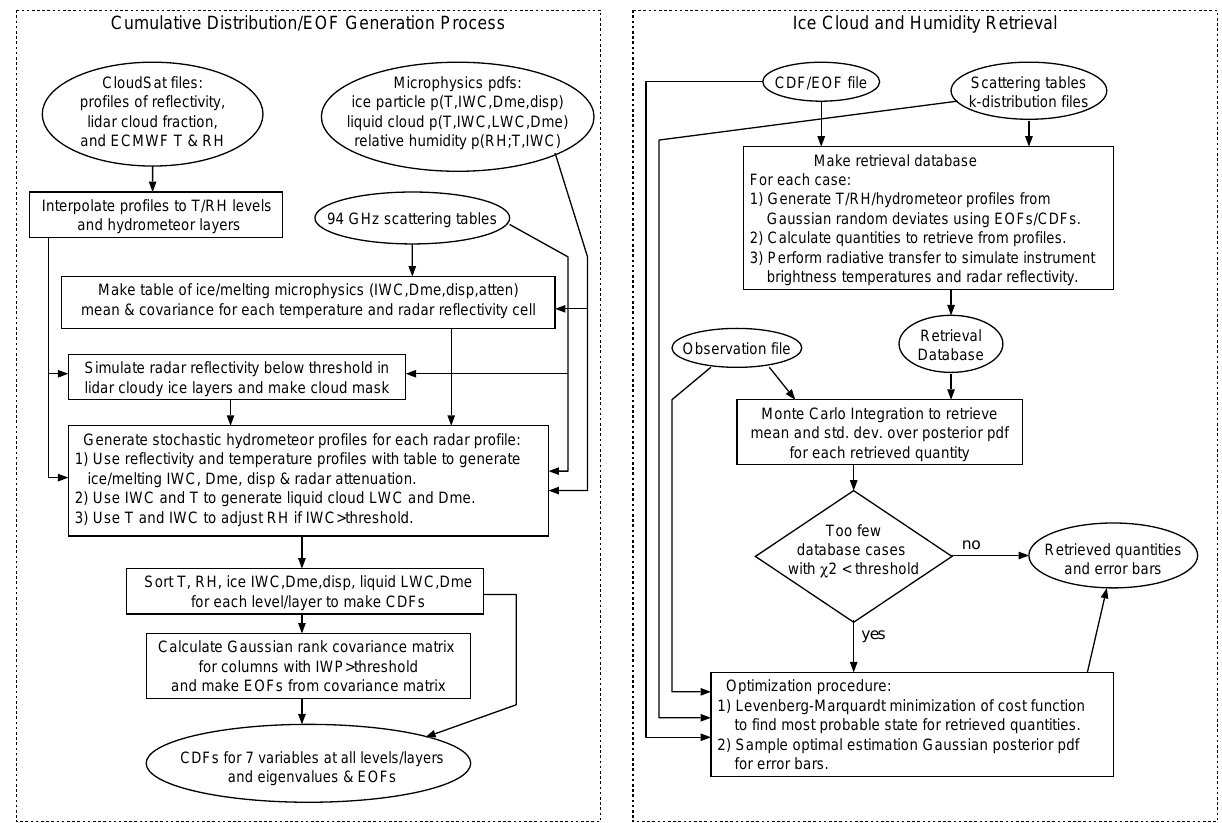
Fig. 1. Flowchart of the Bayesian ice cloud profile retrieval algorithm. Abbreviations used: “ T ” for temperature, “RH” for relative humidity, “IWC” for ice water content, “IWP” for ice water path, “LWC” for cloud liquid water content, “Dme” for mean IWC weighted equivalent sphere diameter, “disp” for D e dispersion (a measure of the size distribution width), “atten” for radar attenuation, “CDF” for cumulative distribution function, “EOF” for empirical orthogonal function, and “pdf” for probability density